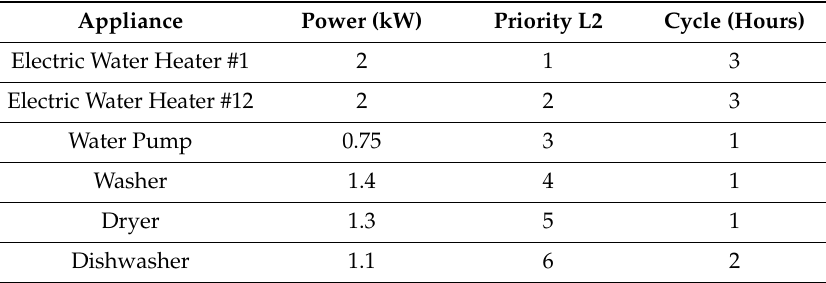
Table 2. Residential appliances